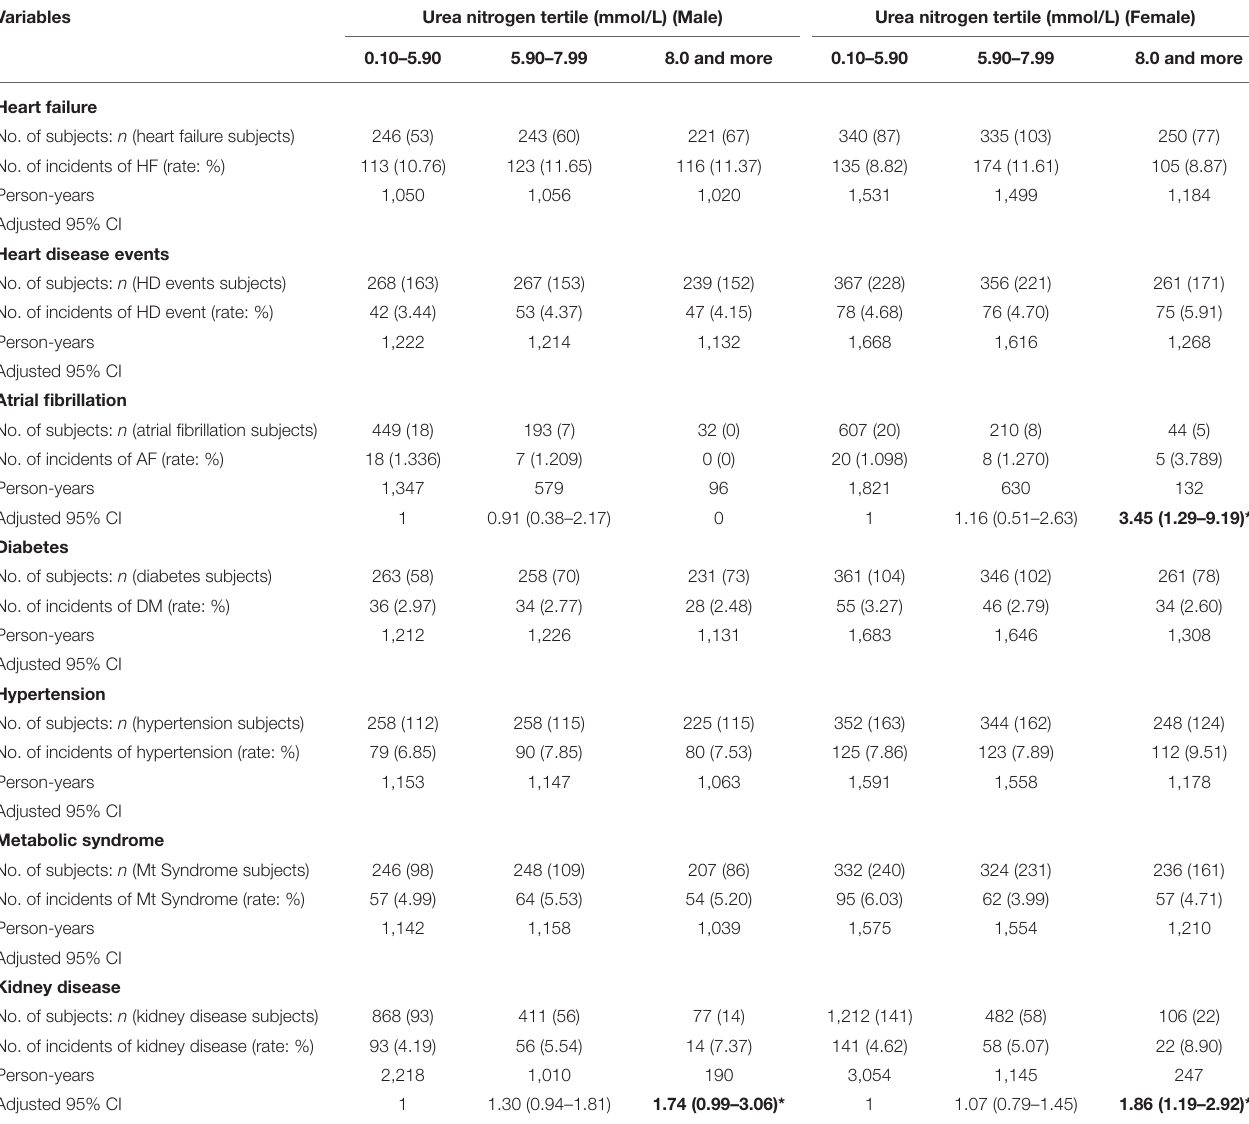
TABLE 3 | Risk of disease by categories of serum urea nitrogen of baseline (raw percentages).